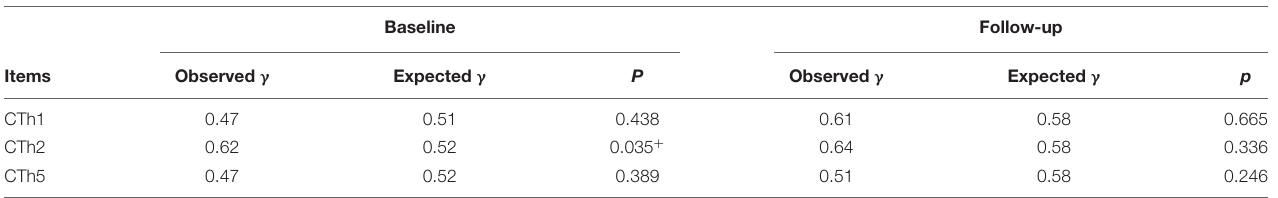
TABLE 2 | Item fit statistics for the Critical Thinking Scale at baseline and follow-up. Baseline